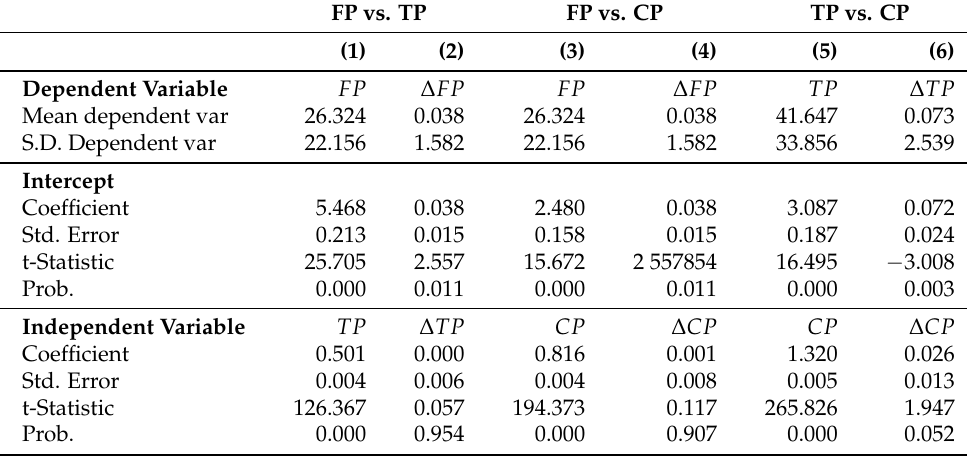
Table A3. Crisis period panel